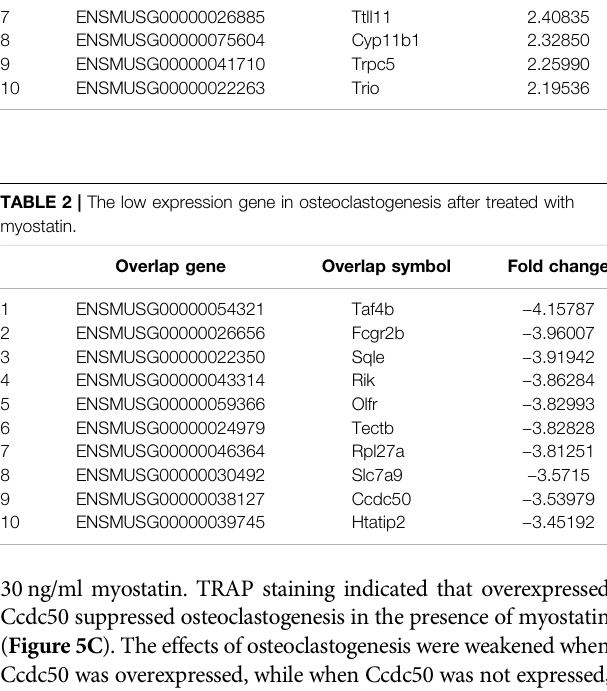
TABLE 1 | The high expression gene in osteoclastogenesis after treated with myostatin. Overlap gene Overlap symbol Fold change